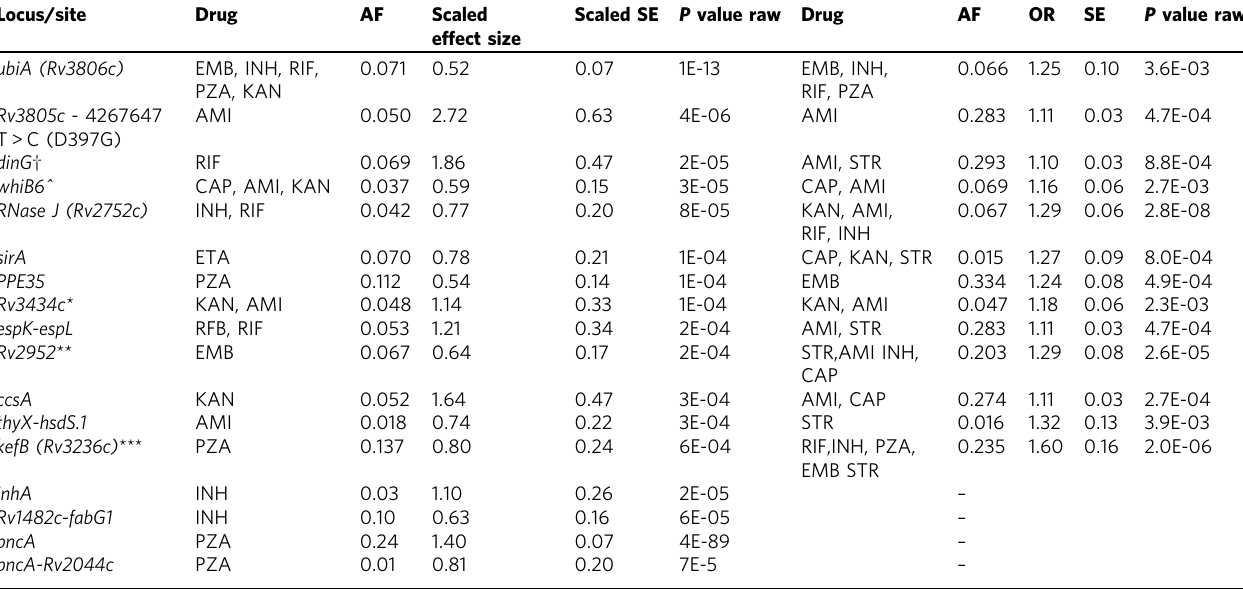
Table 1 Non-canonical regions con fi rmed in the second validation GWAS and four canonical regions for comparison Locus/site